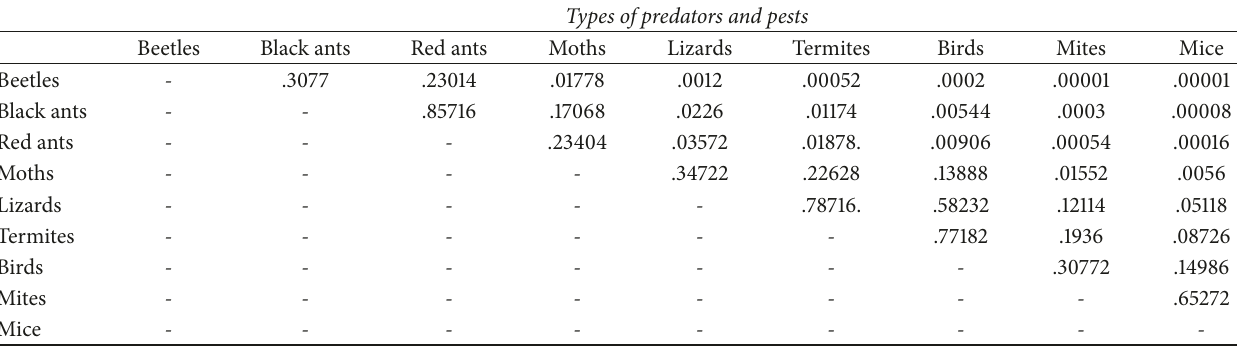
Table 9: P-value matrix for cross tabulation of types of predators/pests.